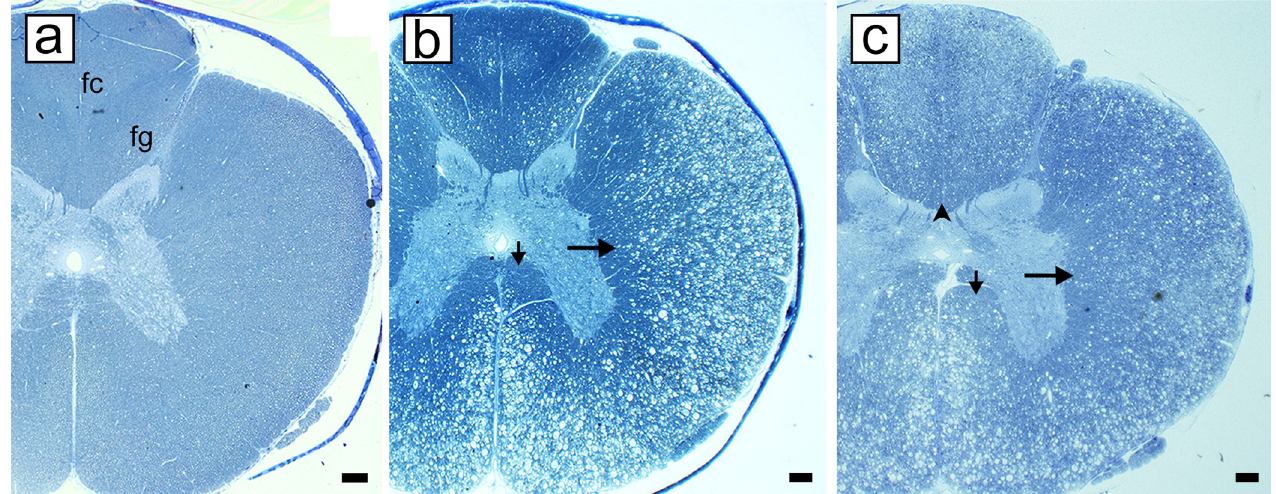
Fig 2. Spread of myelin pathology with time in the spinal cord. a) Control spinal cord. b) In early disease there is extensive vacuolation of the lateral and ventral columns of the thoracic spinal cord with sparing of the deep white matter of the lateral (long arrow) and ventral (short arrow) columns. In the dorsal column there is mild vacuolation of the fasciculus cuneatus but the fasciculus gracilis appears unaffected with the exception of a small area of pallor in the core. c) As the disease progresses, the dorsal column becomes more generally involved, however there is some sparing of the deep white matter (arrowhead) as is the case in the lateral (long arrow) and ventral (short arrow) column. fc = fasciculus cuneatus, fg = fasciculus gracilis. Scale bar: 0.5 mm.